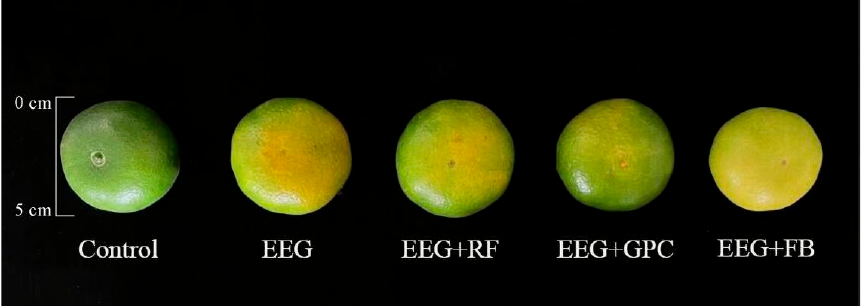
Figure 2. Changes in the fruit appearance of Satsuma mandarin “Oita 4” trees treated by foliar spraying easily extractable glomalin-related soil protein in combination with agronomic strategies. The abbreviations are shown in Figure 1. Table 1. Effects of foliar spraying easily extractable glomalin-related soil protein in combination with agronomic strategies on the external quality of fruits in Satsuma mandarin “Oita 4”. Coloration Treatments Value